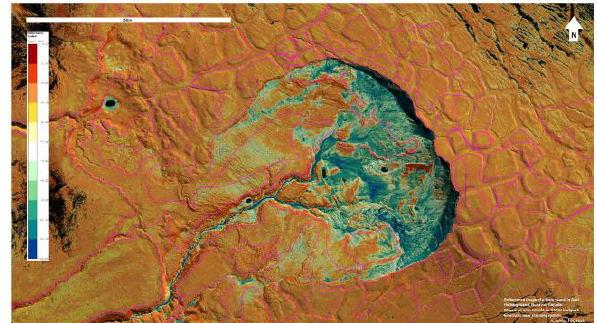
Figure 5. Full point cloud data of the thaw slump. The mapping trajectory is overlaid as a pink string line showing the progress of the data collection in and around. The thaw slump was about 150 m in diameter, the height of the ice face about 10 m.